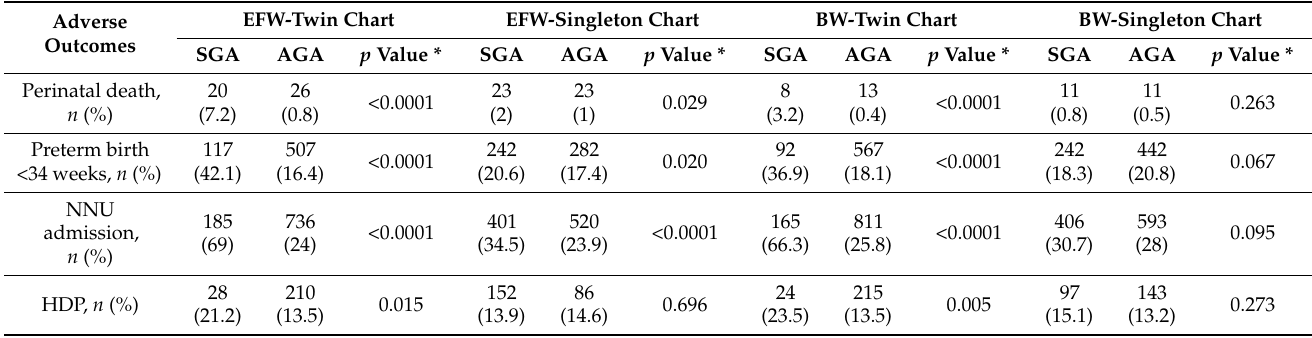
Table 2. Adverse perinatal outcomes in small for gestational age (SGA) fetuses according to twin vs. singleton chart.